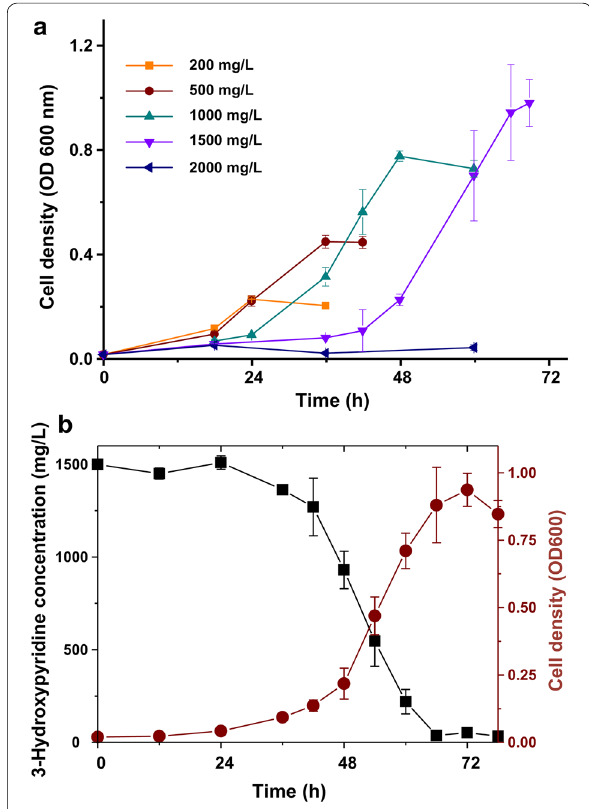
Fig. 4 Effect of 3-hydroxypyridine concentration on cell growth and degradation of strain DW-1. a Growth of strain DW-1 with different concentration of 3-hydroxypyridine. b 3-Hydroxypyridine degradation by strain DW-1 with 1500 mg/L initial concentration. Each value is the mean from three parallel replicates ±